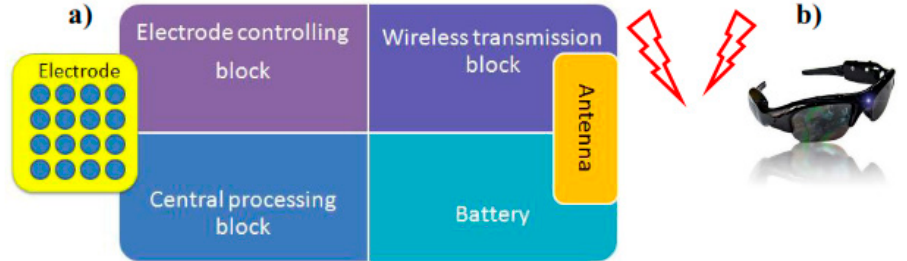
Figure 9. Tongue-placed electro-tactile system with sunglasses carries object detection camera [28] ( a ) sunglasses with detective camera of objects; ( b ) tongue electro tactile device.